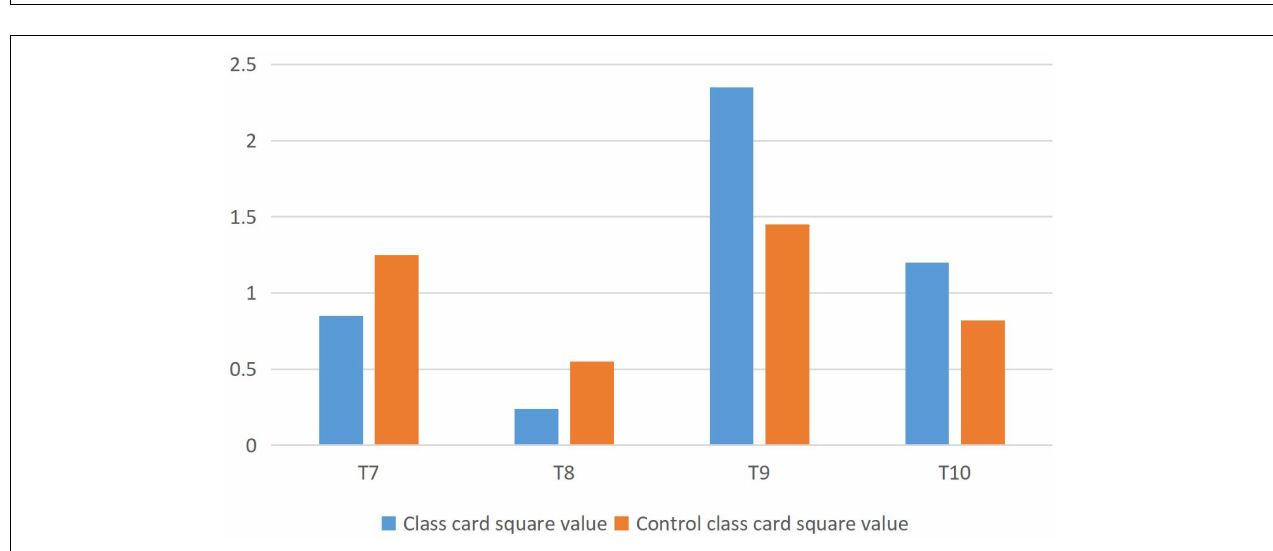
FIGURE 1 | Analysis of students’ learning interest (previous test).